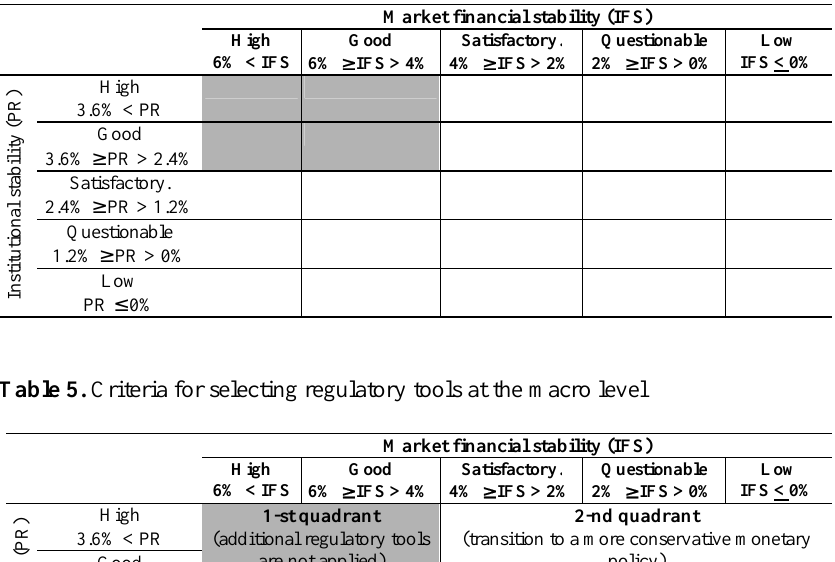
Table 4. Criteria of Market and Institutional balance of Financial Stability